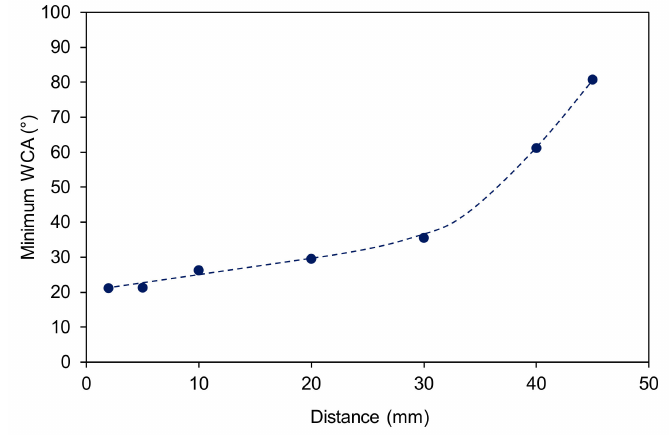
Figure 4. The minimum apparent water contact angle of polystyrene samples treated for 30 s versus the distance.